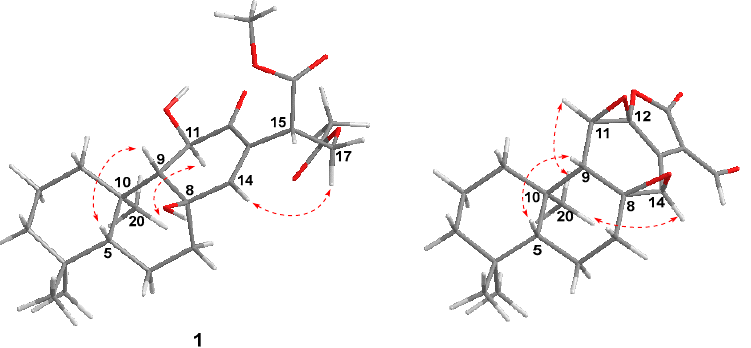
Figure 3. Key NOE correlations ( ) of compounds 1 and 2 .